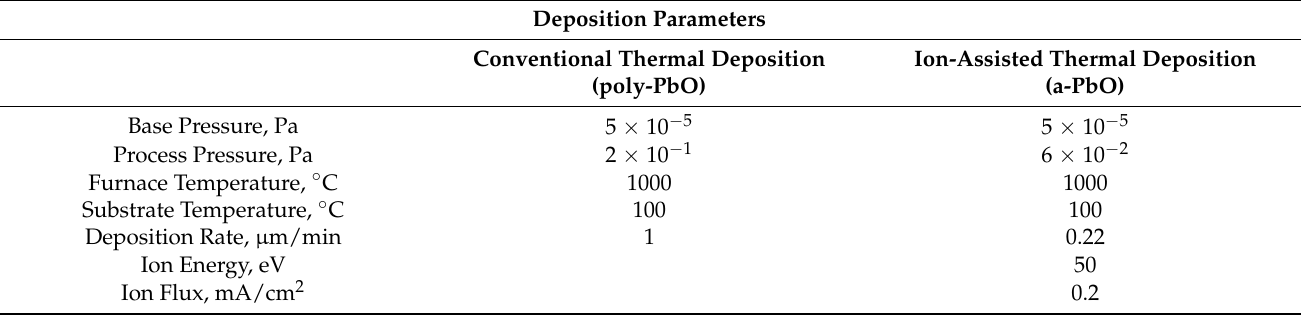
Table 2. Deposition parameters relevant to the deposition of PbO